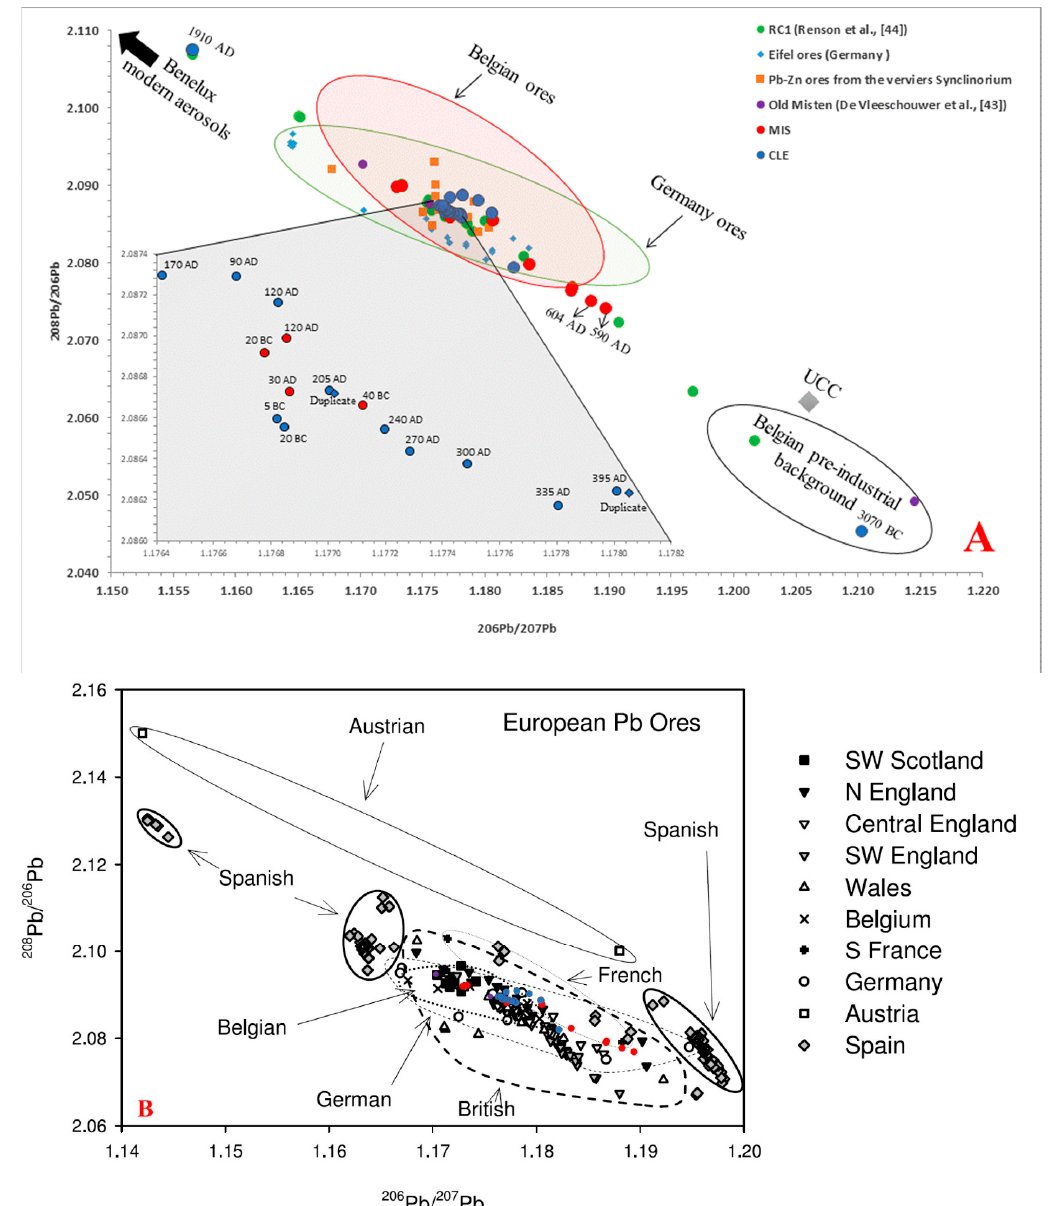
Figure 5. ( A ) Binary diagram 206 Pb/ 207 Pb vs 208 Pb/ 206 Pb. Benelux modern from Bollhöfer and Rosman